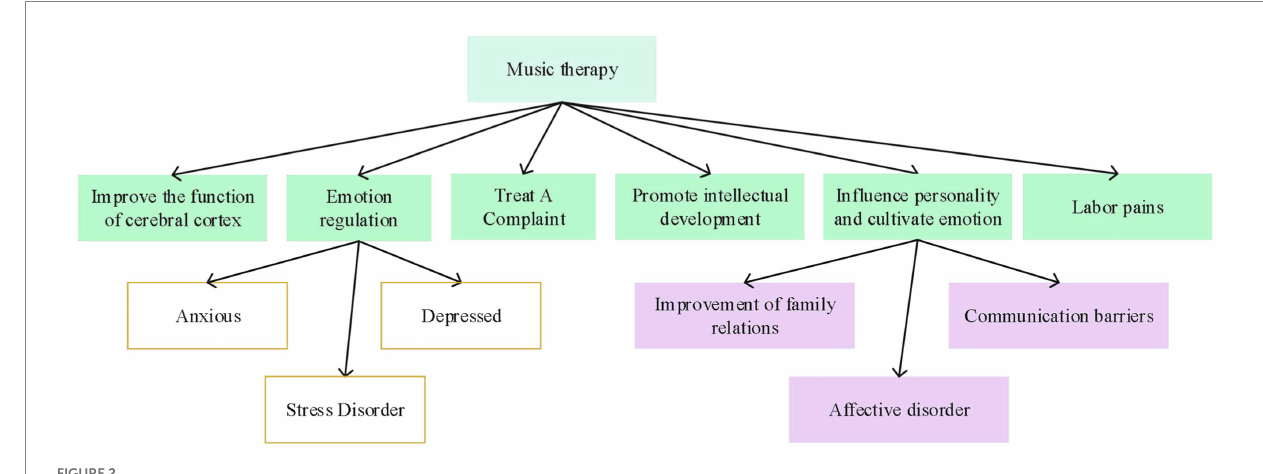
FIGURE 2 Effects of music therapy on physical and mental